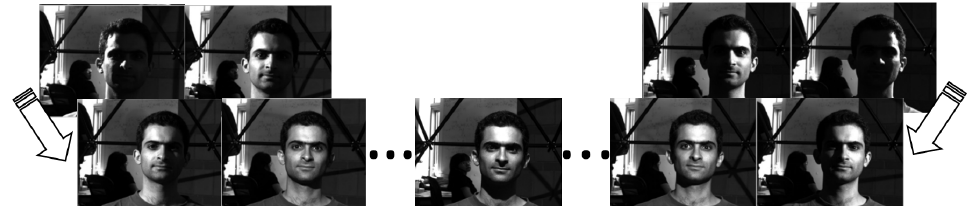
Figure 2. Original image with azimut h angle of +130° to −130°.